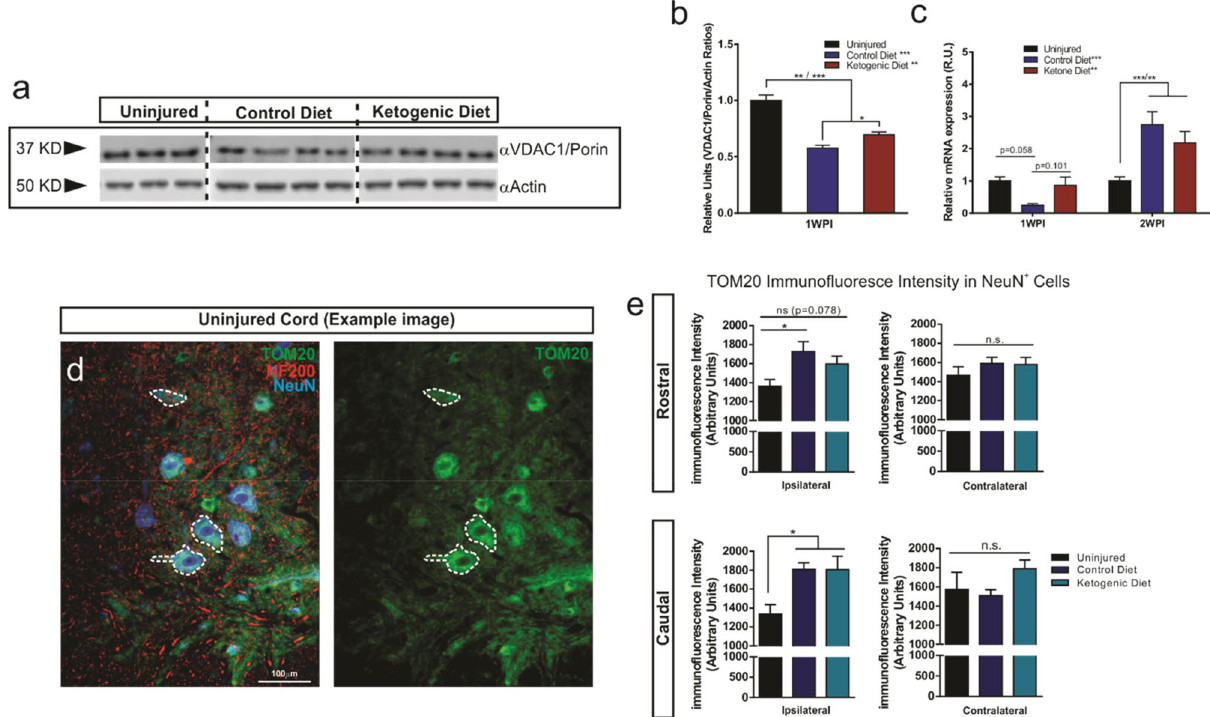
Figure 3. Expression of mitochondrial markers after SCI. ( a , b) Western blot and quantification using an antibody against VDAC1/Porin, an outer mitochondrial ion dependent channel. One-way ANOVA, Fisher’s LSD Post-hoc test. All data are mean ± SEM . ( c ) Relative gene expression of Peroxisome proliferator-activated receptor gamma coactivator 1-alpha (PGC-1α). The expression levels of mRNAs were measured by real-time PCR. Values represent relative expression levels of PGC1-α in uninjured rats (n = 5) compared to the injured spinal cord of KD rats (n = 6) compared with CD rats (n = 6). Two-way ANOVA, Tukey’s Post-hoc test. All data are mean ± SEM. ( d , e ) Example high magnification micrograph of the ventral horn of an uninjured spinal cord stained with TOM20 (mitochondria), NF200 (Neurofilament) and NeuN (D). Intensity quantifications of the mitochondrial import receptor subunit (TOM20) from randomly outlined NeuN + cells (n = 9–12) ( e ). One- way ANOVA, Fisher’s LSD Post-hoc test. All data are mean ± SEM. Two different mitochondrial markers both targeting outer mitochondrial membrane proteins were used due to its differential effectiveness in detecting the target in western blots or in immunofluorescence. The blots from the same gels were cropped and rearranged in the following order: Uninjured, Control Diet, Ketogenic Diet; to make them more clear and enhance reader’ understanding of the figure and the subsequent quantifications. Membranes were cut previous incubation with primary antibodies in order to optimize limited sample use. Full-length blots/gels are presented in Supplementary Fig. KD group compared to the CD group (93.22% increase, p = 0.026). However, no significant changes in STAT3 phosphorylation levels after SCI nor between treatment groups was detected (Fig. 4a,b).